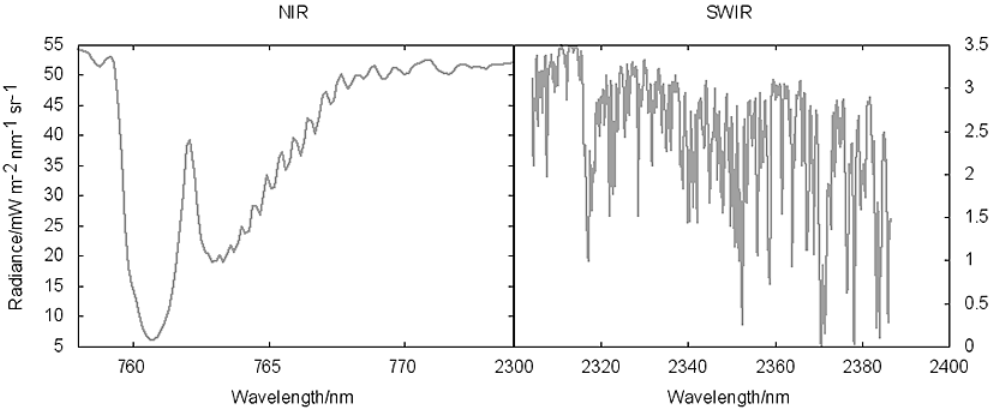
Figure 1. Simulated TROPOMI spectra in the NIR and SWIR channels for a scenario from the global ensemble; see Sect. 3.1. The scenario, located in a rural area in Utah (USA), is observed at nadir and SZA = 50 ◦